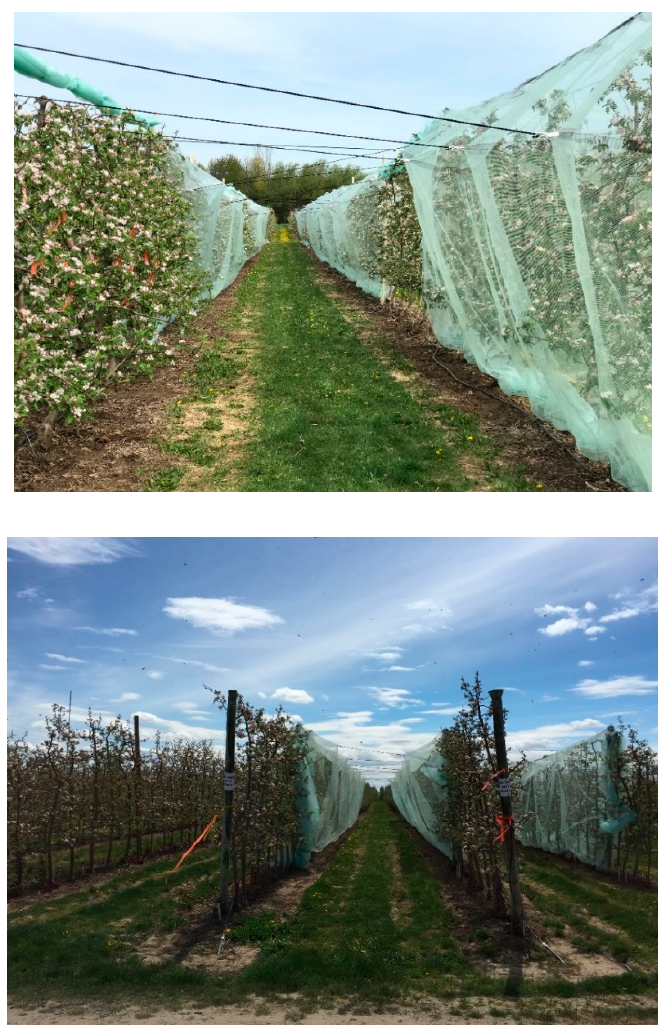
Figure 1. Experimental sites of 10-year-old ‘Gala’ in Michigan ( A ) and 9-year-old ‘Honeycrisp’ in Washington ( B ) for Alt’ Carpo exclusion netting. Tree density was 2988 trees per ha at both sites.